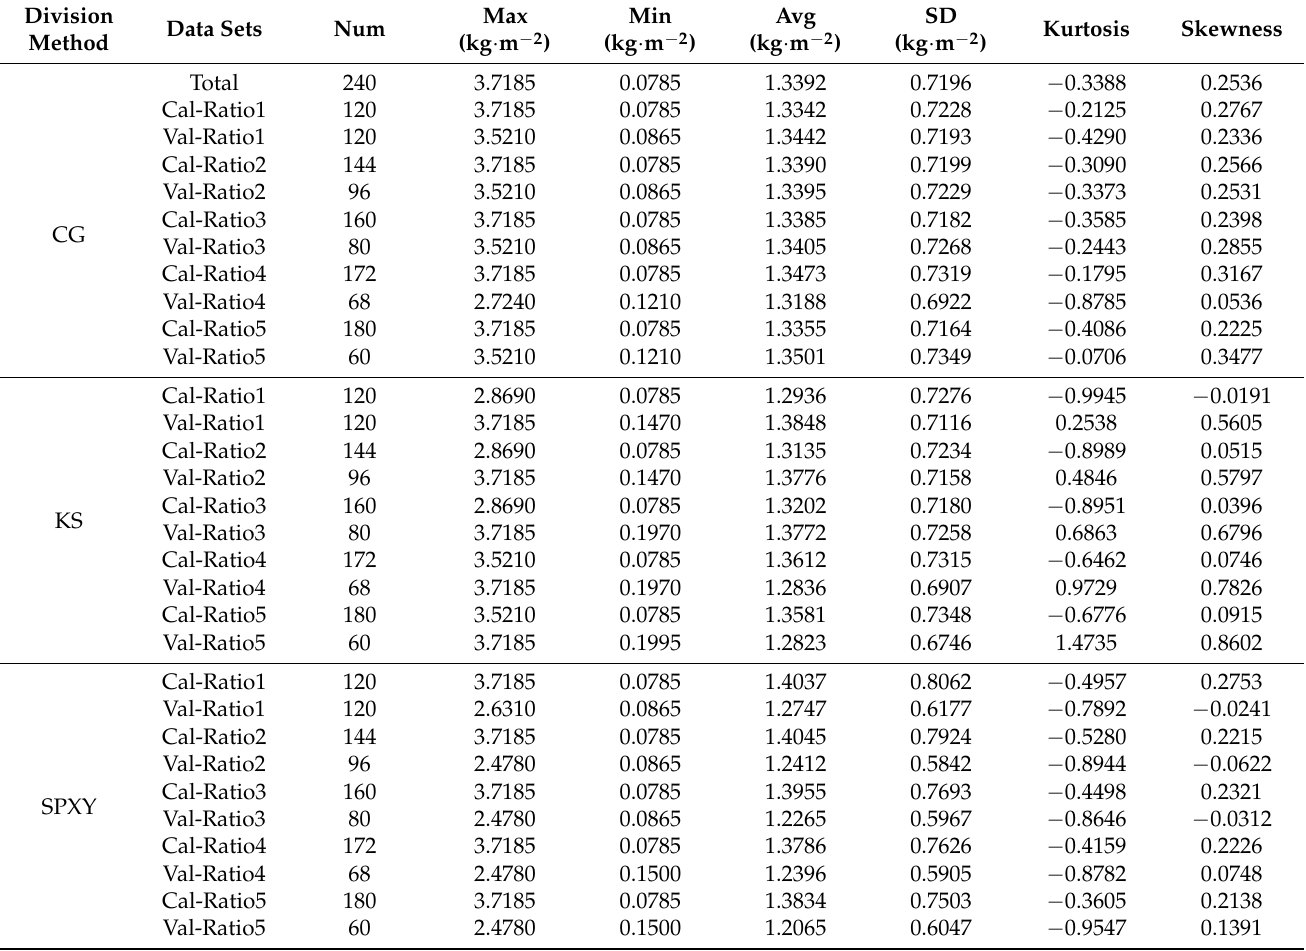
Table 1. Division effect of different sample division methods and